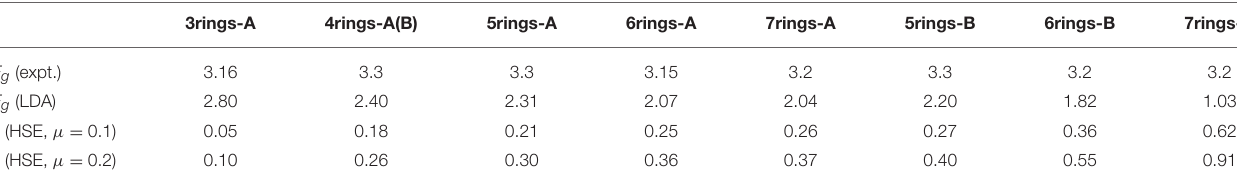
TABLE 1 | Based on the LDA, the calculated band gap ( E g ) is smaller than the experimental one for each PAH. Reproducing the experimental band gap, the values of the µ and ν parameters are presented. 3rings-A 4rings-A(B)